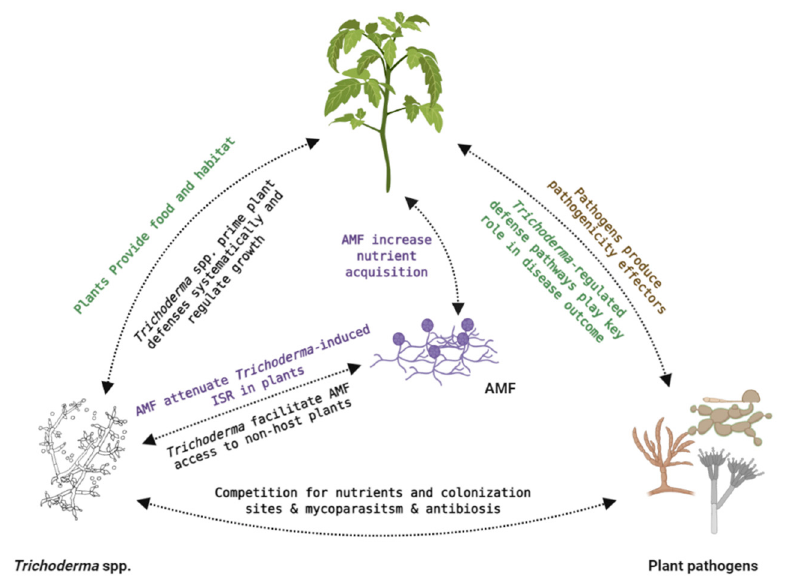
Figure 2. A schematic diagram displaying simplified glimpse of possible crosstalks between Trichoderma spp., plant pathogens, other beneficial microbes (i.e., arbuscular mycorrhizal fungi (AMF)) and plants.